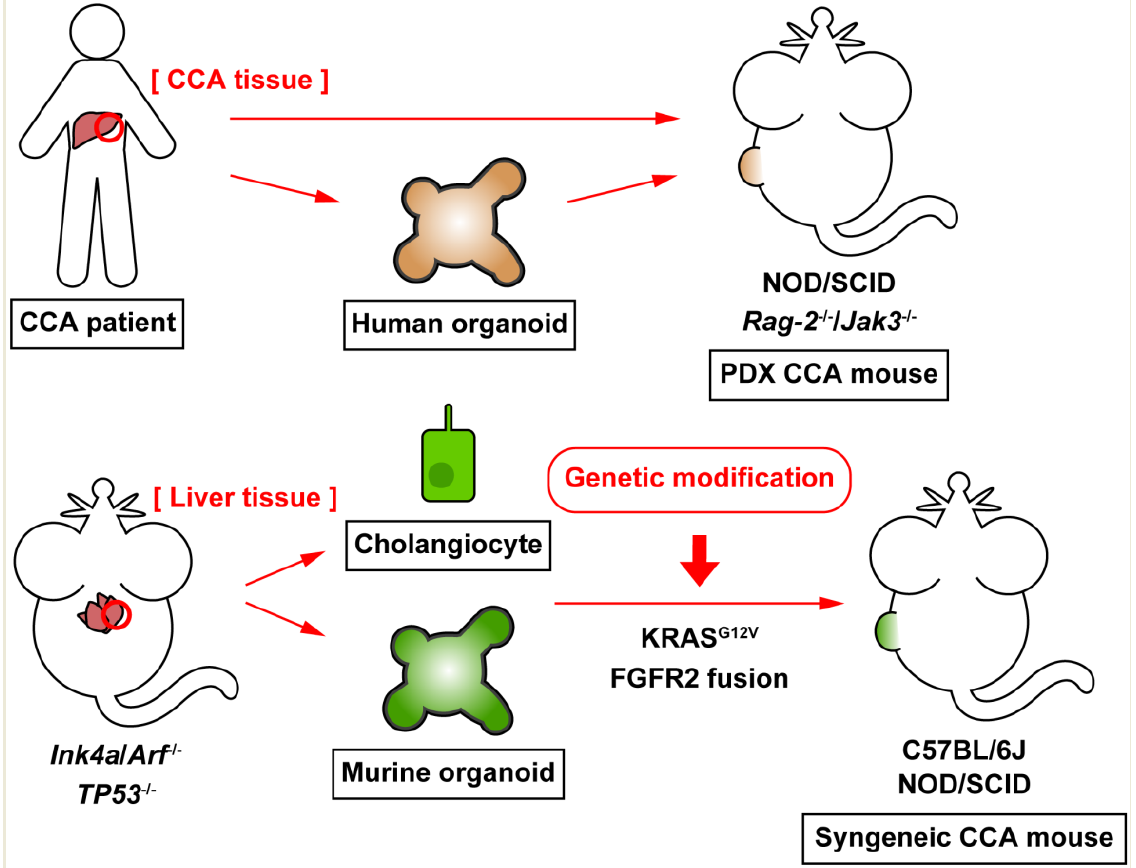
Figure 1. Current advances in experimental models of cholangiocarcinoma (CCA). CCA tumor tissues excised from patients can be engrafted in immunodeficient mice, such as NOD/SCID mice, to generate patient-derived xenograft (PDX) mouse models. CCA organoids, which are established from CCA tumor tissues, resemble 3D cellular architecture, and maintain functions of CCA tumor cells. Human CCA organoids can be transplanted into mice to generate xenograft animals. Murine cholangiocytes or hepatic organoids, which are derived from knockout mice for tumor-suppressor genes become malignant by genetic modification, such as KRAS activation or FGFR2 fusion protein expression, and these malignant cholangiocytes or organoids establish CCA tumors in WT or immunodeficient mice. These syngeneic CCA mouse models overcome the mismatch of species between CCA tumors and the host animals. Table 2. Brief characteristics of current CCA animal models.